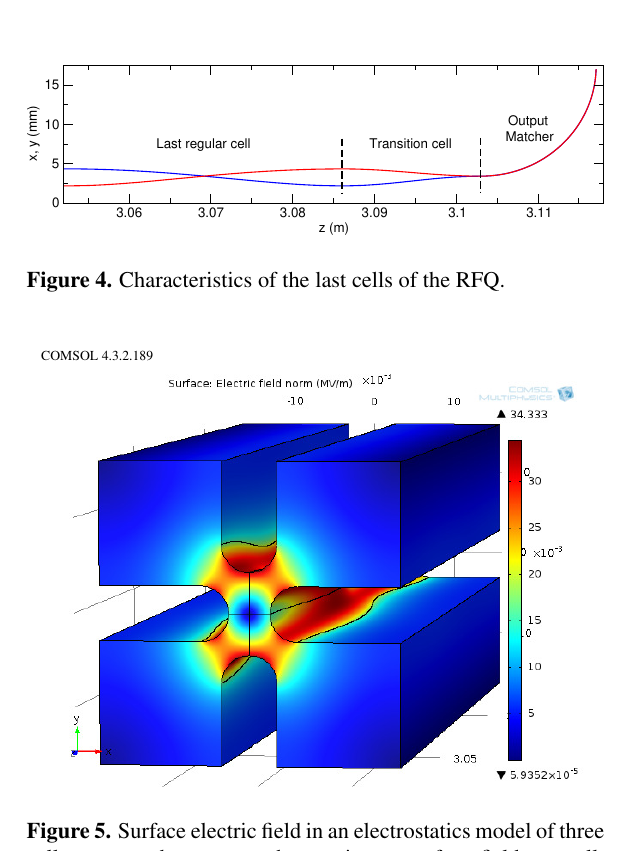
Figure 3. Modulation amplitude and accelerating field for ESS-Bilbao RFQ.